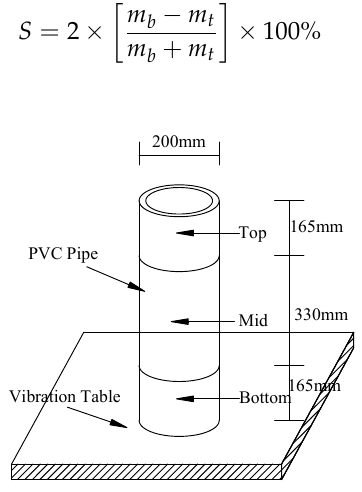
Figure 1. The segregation test device of pervious concrete.